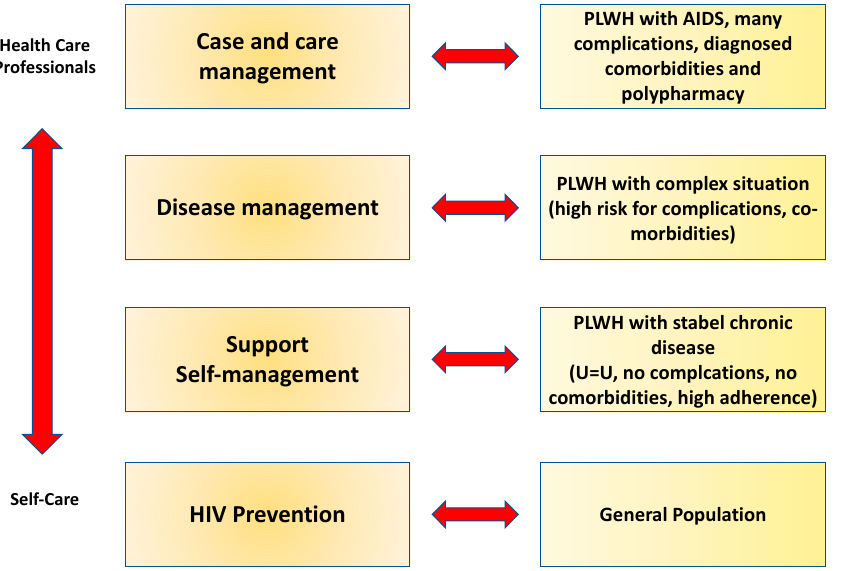
Figure 5. Integrated care for PLWH modified population-based Kaiser Permanente model (WHO 2016 [33]).